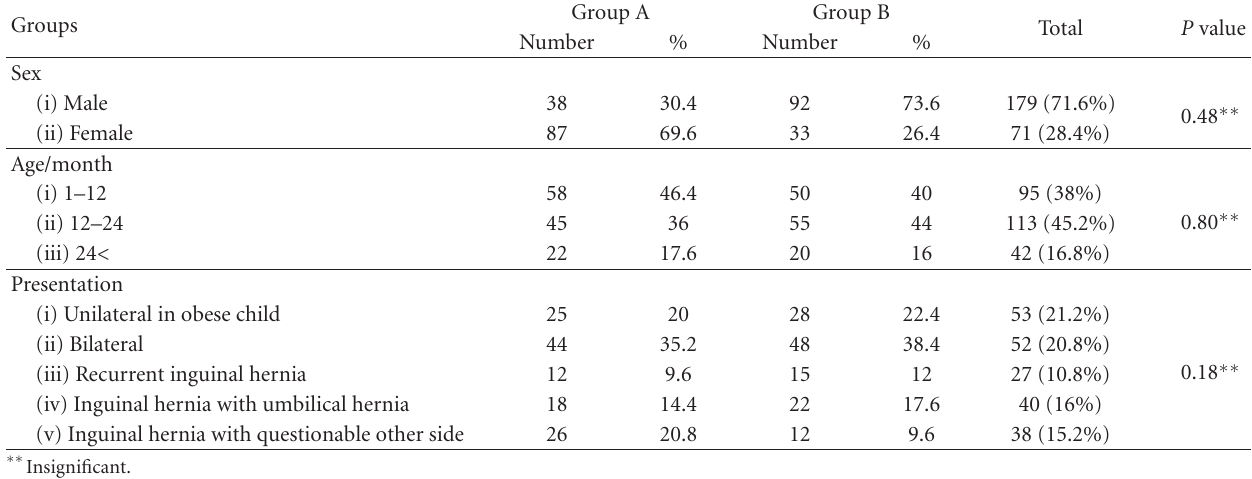
Table 1: The demographic data for the two groups.